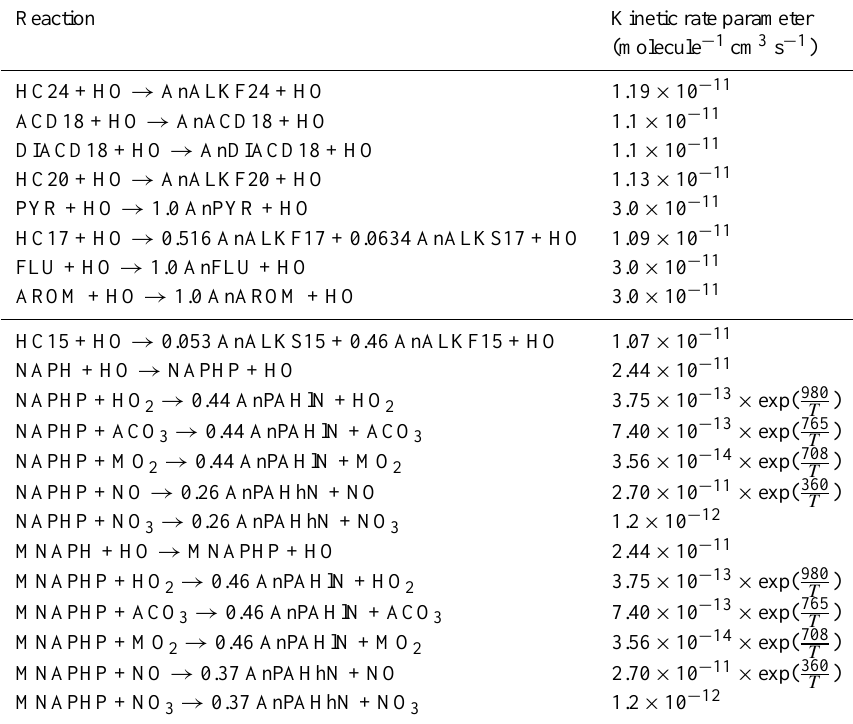
Table 2. Reactions of oxidation of primary SVOC (top panel) and IVOC (bottom panel) species (the oxidant species is listed as both reactant and product to ensure that the gas phase mechanism is not affected by these additional reactions).